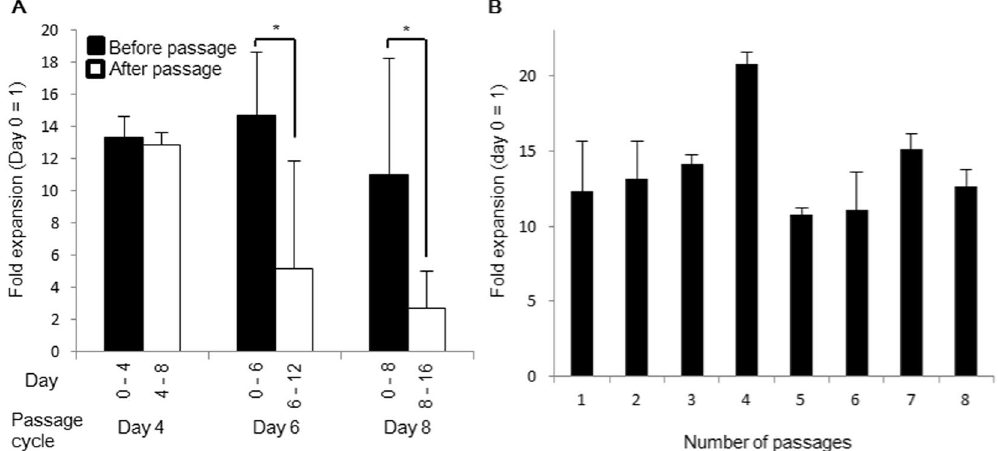
Figure 5. Passaging of human iPS cells in the core-shell microfiber culture system. ( A ) Expansion rates of human iPS cells cultured in the microfibers accompanied with collagen at low initial cell density (1.0 × 10 7 cells/ mL) before and after passage (N ≥ 3). The cells were passaged on day 4, 6, or 8. * P < 0.05. ( B ) Expansion rates of the cells cultured in the microfibers by serial passaging (N ≥ 3). Cells were passaged every 4 days and cultured until 8 passages (32